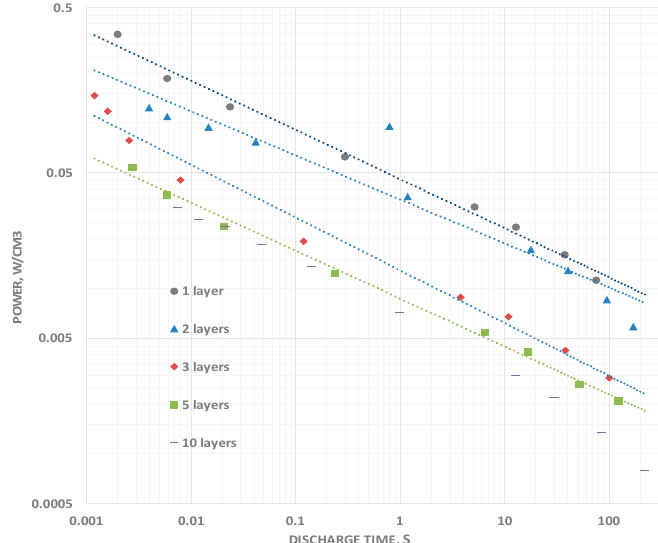
Figure 6. Power vs. Discharge Time. The power observed decreases monotonically with the number of layers. Notably, the power increases with decreasing discharge times. This is because the roll-off of energy is slower than the “roll-off” of discharge time.